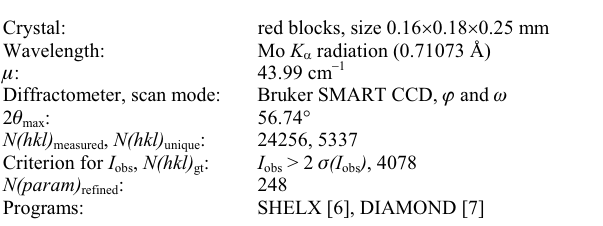
(fig ure, top), with all the bond lengths be ing within nor mal ranges. Two mol e cules are packed in the unit cell. The ob served intermolecule in ter ac tions are C–H···F, and C–H··· (cid:3) in ter ac tions (fig ure, bot tom). There are two types C–H···F in ter ac tions gen er - ated in the crys tal lat tice. One is the con ven tional C–H···F hy dro -